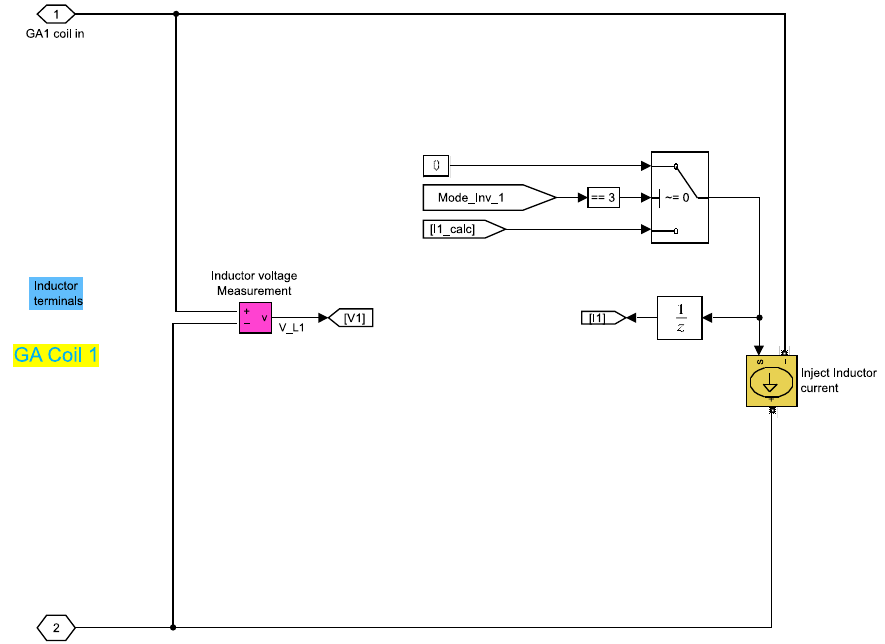
Figure A2. The control circuit of each inverter with PWM generation.